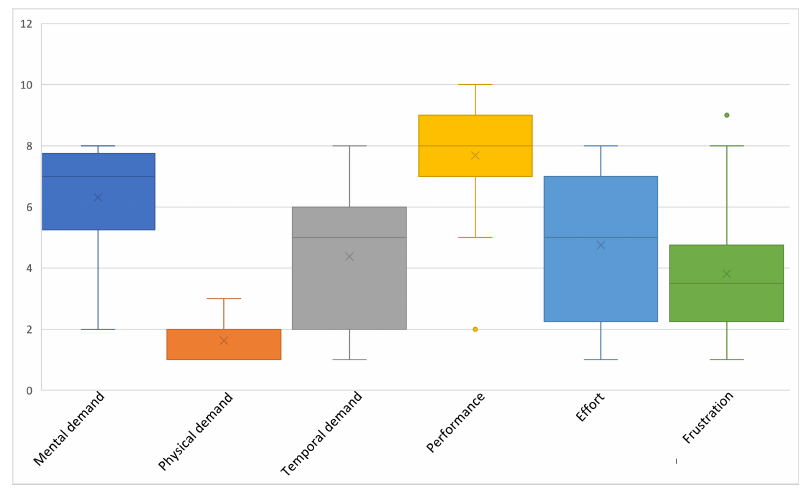
Figure 14. A boxplot of the NASA-TLX results for the correlation analysis of multivariate data use case. Each of the six subscales was captured with a 10-points continuous scale from very low (1) to very high (10) . The X-axis indicates the sub-dimensions of the score. The Y-axis indicates the statistics for each sub-dimension.